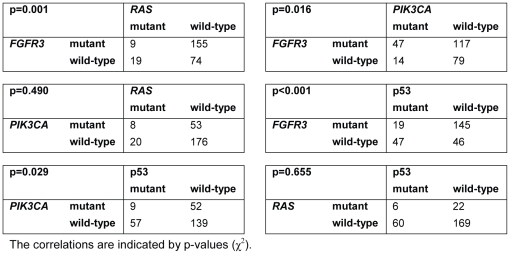
Relations between mutations in primary bladder tumors of 257 patients.